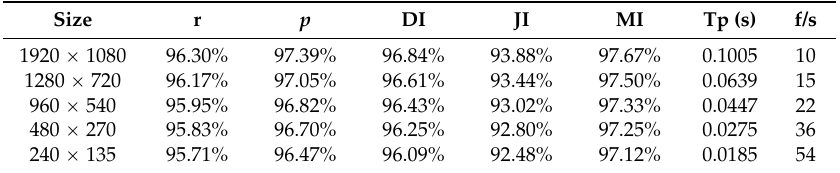
Table 2. Average metrics obtained over 50 resized test images.